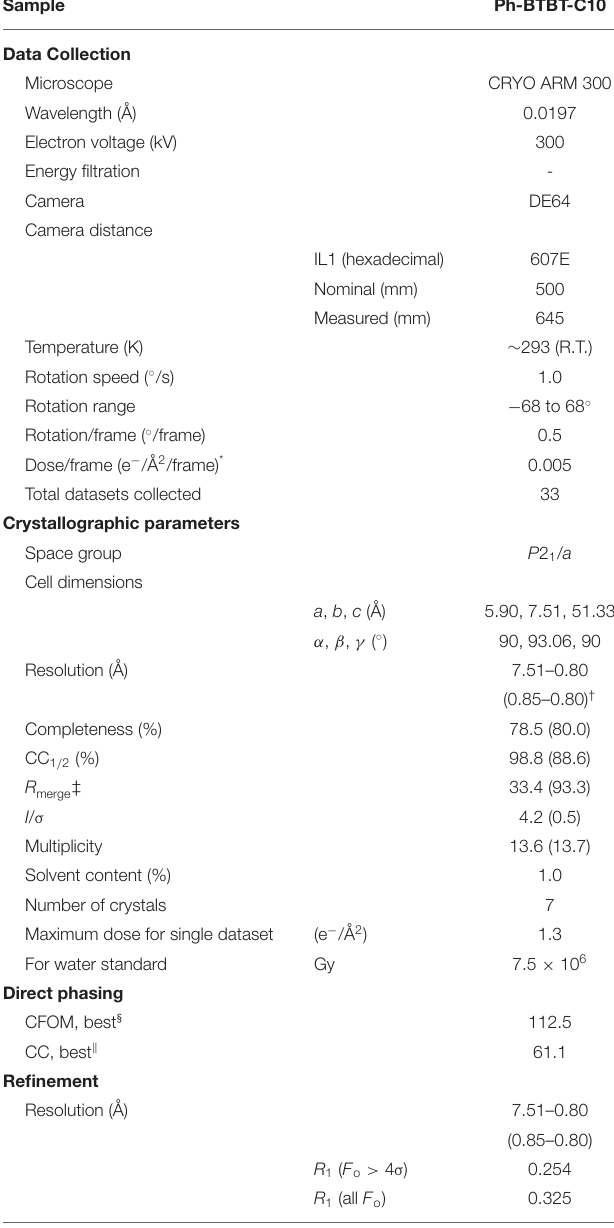
TABLE 2 | Data collection, crystallographic, and refinement statistics of